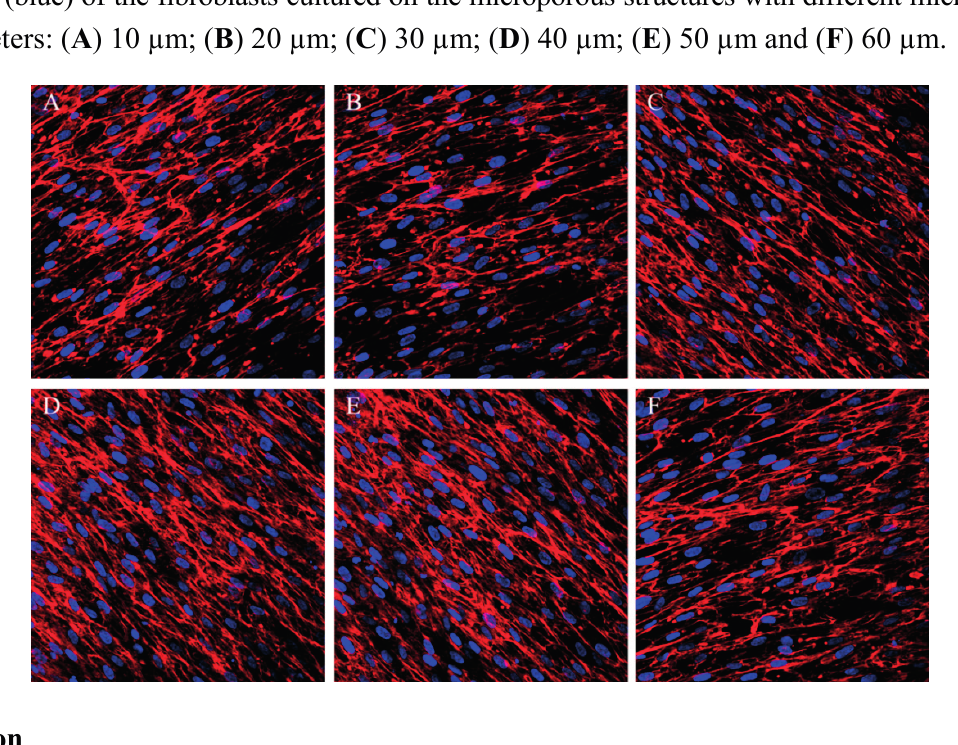
Figure 5. Immunofluorescence staining of fibronectin (red) and nuclei counterstaining, with DAPI (blue) of the fibroblasts cultured on the microporous structures with different